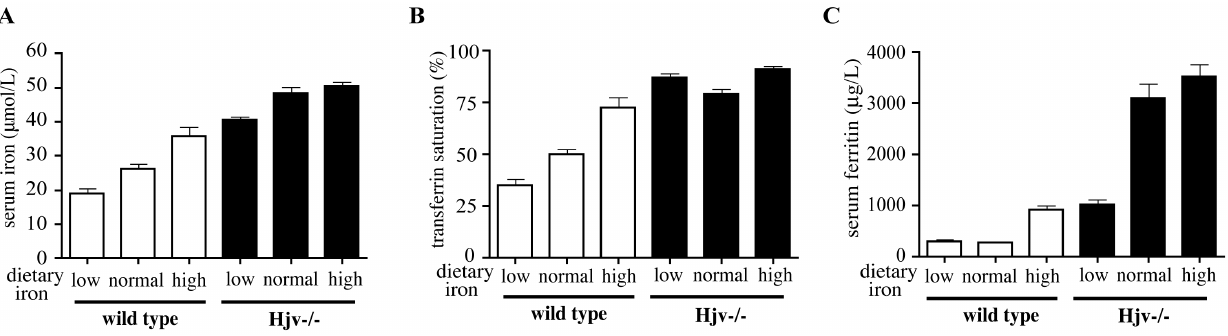
Figure 1. Hjv 2 / 2 mice exhibit elevated serum iron indices independently of dietary iron intake. Ten-week old male Hjv 2 / 2 and wild type mice (n=10 for each group) in C57BL/6 background were placed on diets with variable iron content (low: 75–100 ppm; normal: 225 ppm; high: 225 ppm plus 2% carbonyl iron). After four weeks the animals were sacrificed and sera were analyzed for iron (A), transferrin saturation (B), and ferritin (C). Data are presented as the mean 6 SEM. Statistical analysis is provided in Table